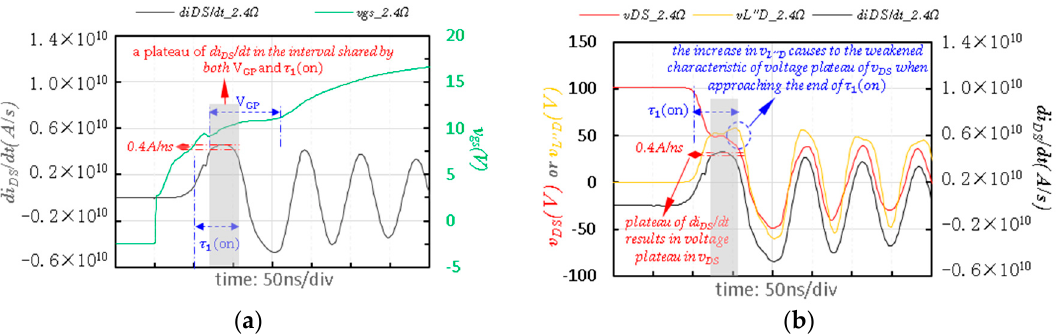
Figure 15. The simulation results about mechanism of drain-source voltage plateau under 100 V / 100 A: ( a ) plateau di DS / dt , ( b ) comparison of v L (cid:48)(cid:48) D and v DS